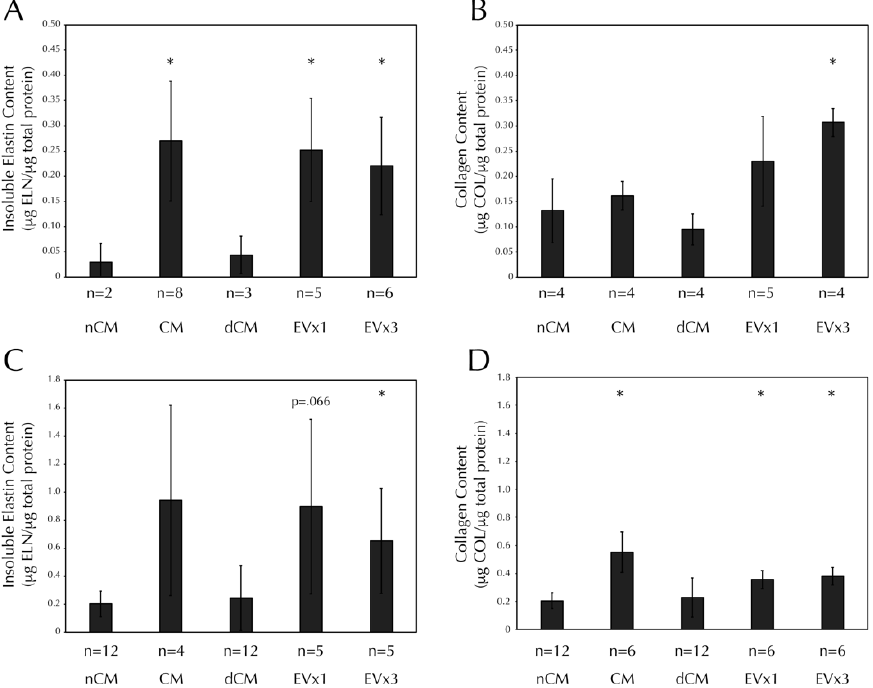
Figure 3. SMC insoluble elastin and collagen deposition in both discs and strands are increased after 30 days of CM or EV treatment, but not dCM. All fibrin constructs were cultured as in Figure 2. ( A ) Insoluble elastin deposition by Scheme 30. days of stimulation with CM, EV × 1, and EV × 3 relative to the negative control, nCM. ( B ) Total collagen deposition by SMCs in fibrin discs was increased after 30 days of stimulation with 3 × EV relative to nCM. ( C ) Insoluble elastin deposition by SMCs in fibrin strands was increased after 30 days of stimulation with 3 × EV relative to nCM. ( D ) Total collagen deposition by SMCs in fibrin strands was increased after 30 days of stimulation with CM, EV × 1, and EV × 3 relative to nCM. Sample size is indicated for each group. * = p < 0.05 relative to nCM.